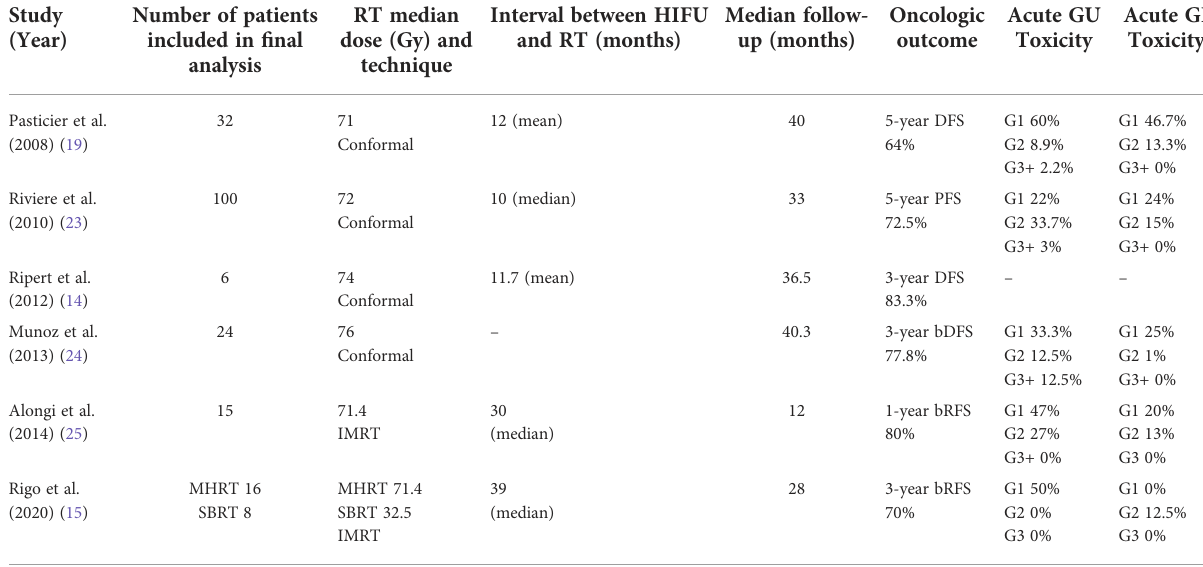
TABLE 4 Studies exploring salvage RT outcomes after HIFU